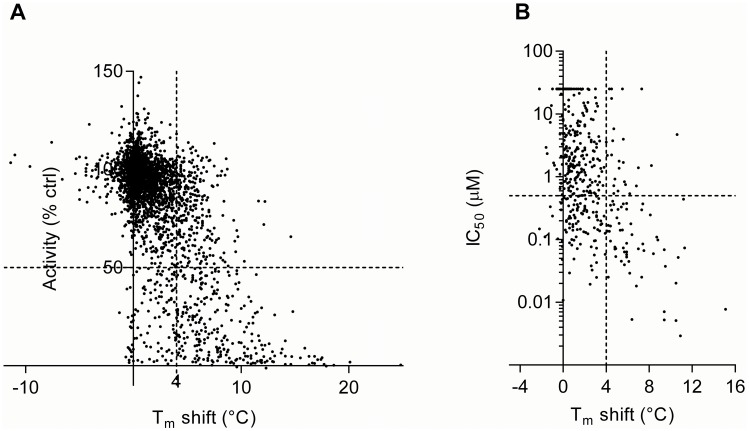
Binding and activity-based screening data comparison based on kinase-inhibitor pairs.
A, Recreation of a scatter plot from Anastassiadis et al. [2] with comparison of their data, % activity of control (Ctrl) at 0.5 µM compound with Tm shift data obtained from Fedorov et al.
[5]. (B) Scatter plot comparison of our IC50 and Tm shift data. The dashed horizontal line corresponds in A to 50% activity at 0.5 µM compound and in B to an IC50 of 0.5 µM. The dashed vertical line in the plots of 4°C Tm shift corresponds to a binding affinity <1 µM. A significant correlation of binding and inhibition is observed for both analyses (P<0.001).